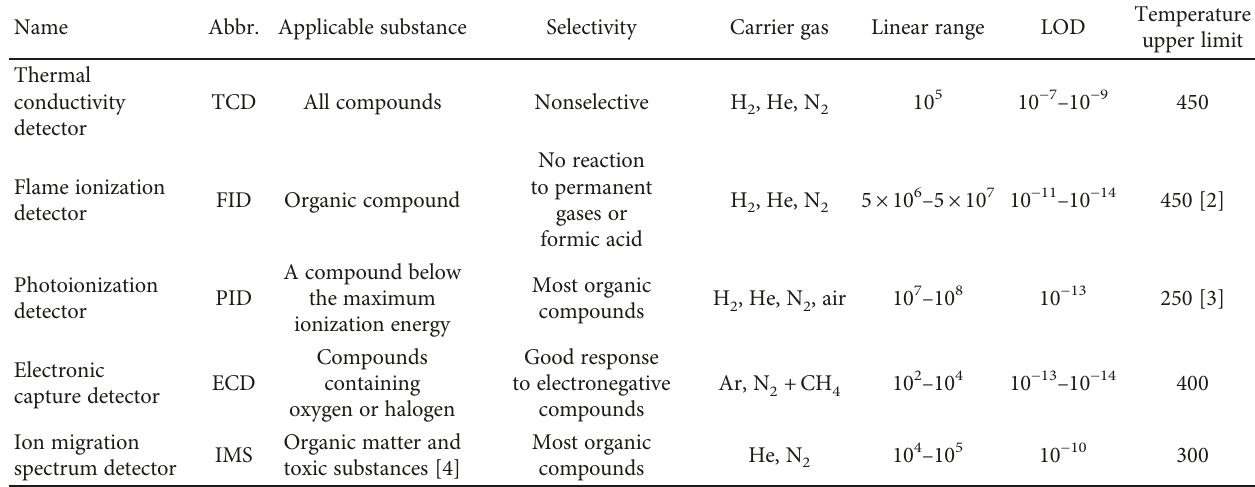
Table 1: Performance comparison table of odor